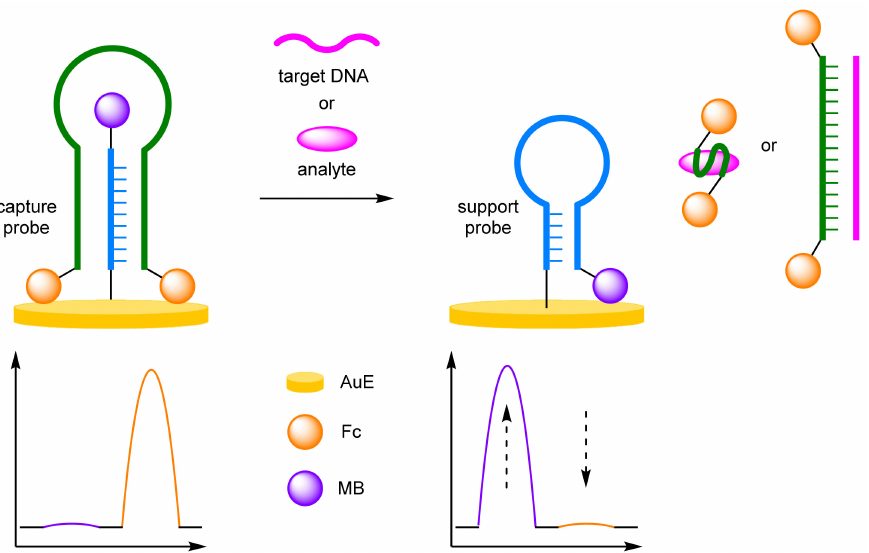
Figure 12. Schematic representation of triple-helix molecular beacon-based biosensor for either target DNA or analyte